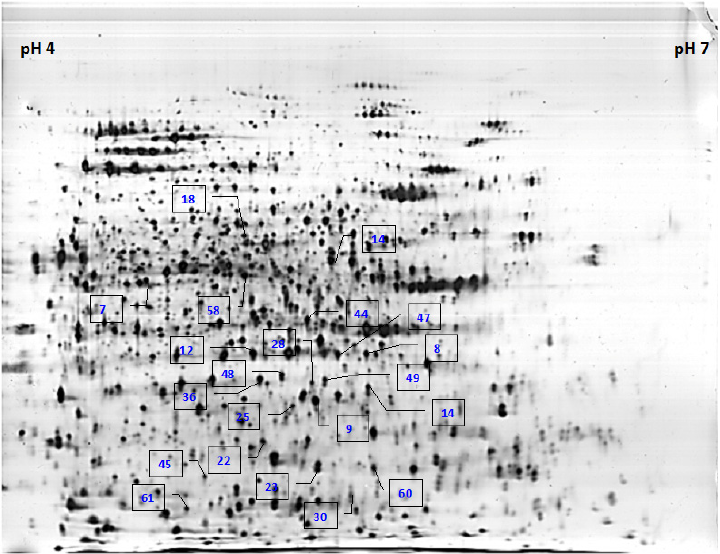
Figure 2. A representative 2-DE profile of control oil palm root proteins harvested at two weeks. Twenty-one proteins whose abundances were significantly altered are labeled with their protein ID numbers in the gel.